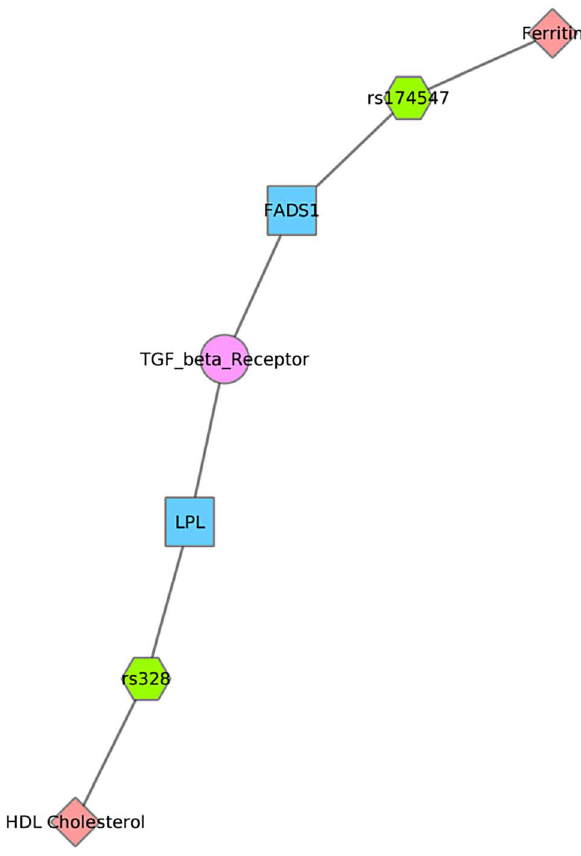
Fig. 8. Using PheWAS results, Biofilter, and Cytoscape to explore gene-gene connections with NetPath. We used Biofilter to annotate the SNPs of this PheWAS with gene information. We then mapped the genes to concomitant pathways or other gene groupings through GO, KEGG, and NetPath. This is one example for the results for Mexican Americans and annotation with NetPath. The pink diamonds are associated phenotypes of this PheWAS, the green hexagons are SNPs, blue boxes are genes, and circles are biological connections that link genes together, in this case the two genes are in the same TGF NetPath biological pathway. Thus, we see that in the PheWAS results, the LPL SNP rs328 had a significant association with HDL cholesterol levels, and FADS1 rs17547 association with Ferritin levels, and both genes are found in the TGF beta receptor pathway.